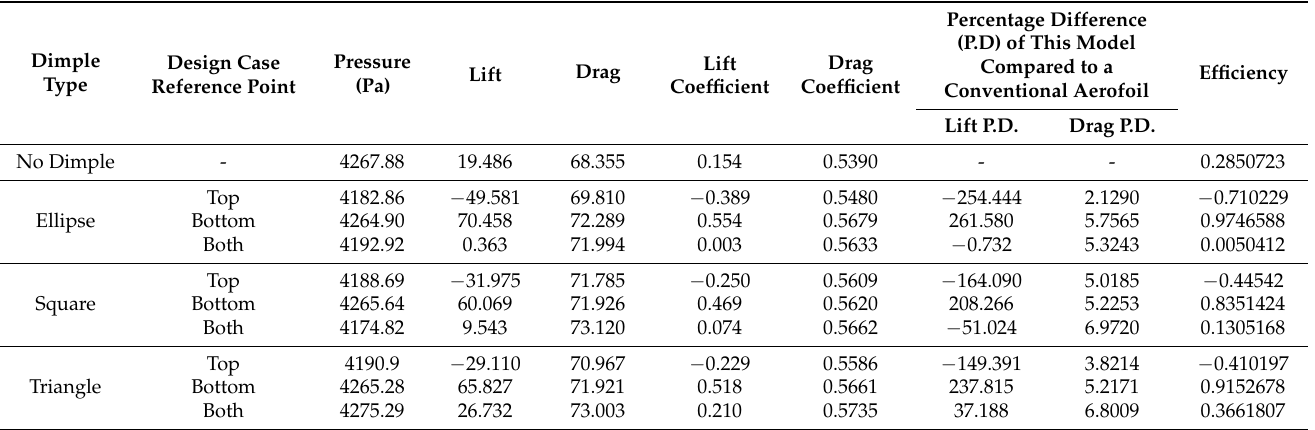
Table 10. Results of a dimpled wing in comparison to a smooth one.